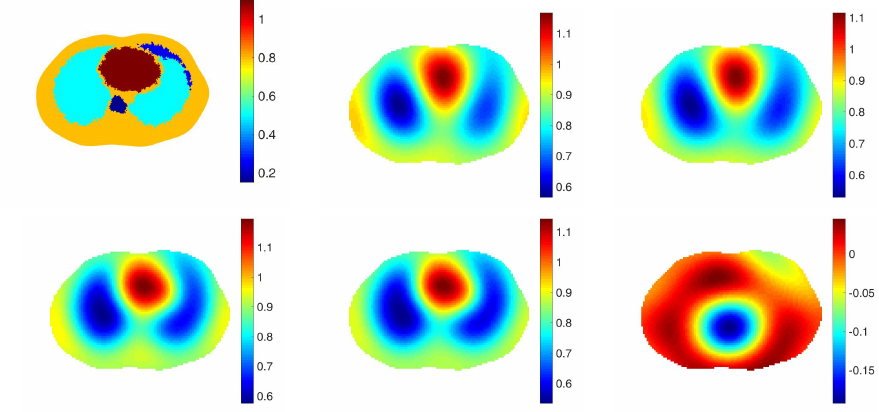
Figure 3. Small pneumothorax. From top left: The true conductivity distribution, reconstruction of γ abs with no prior, γ diff with no prior, γ abs pr with the spatial prior, γ diff pr with the spatial prior, a difference image in which the data for the example of healthy heart and lungs in Figure 2 with no pathology is chosen for γ ref . The L2 norms of the differences between those reconstructions and the ground truth are 0.3038, 0.3137, 0.3013 and 0.3112 in